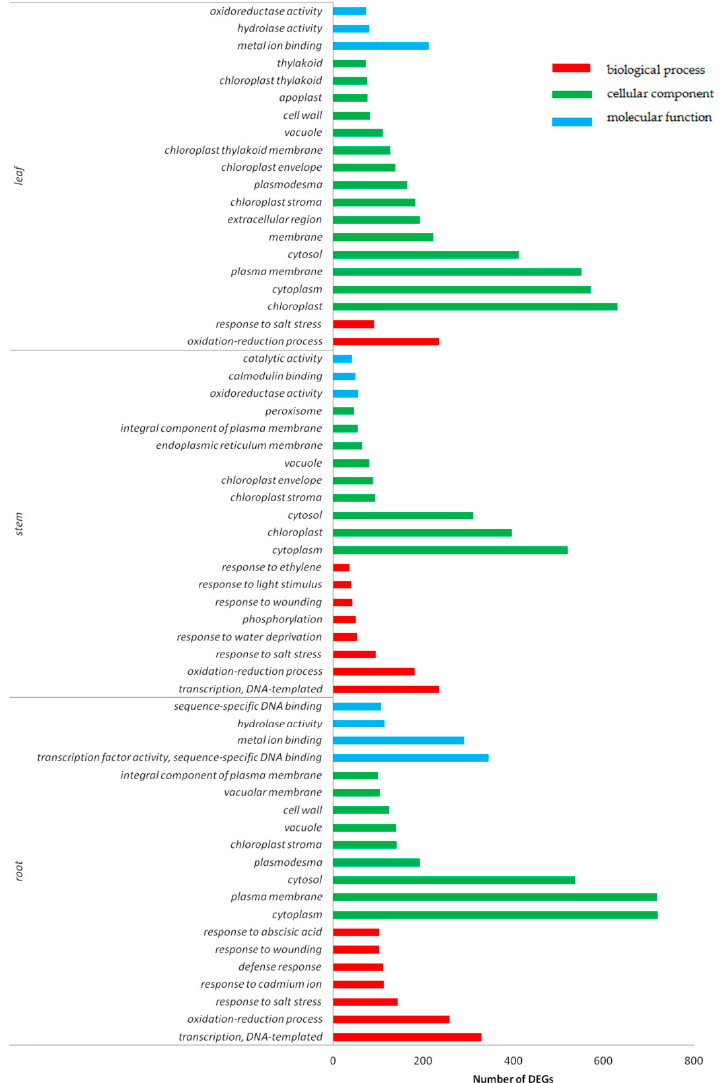
Figure 5. GO (gene ontology) function classification of DEGs in roots, stems, and leaves under Cd stress. Red color represents the biological process, green color represents cellular component, and blue color represents molecular function.